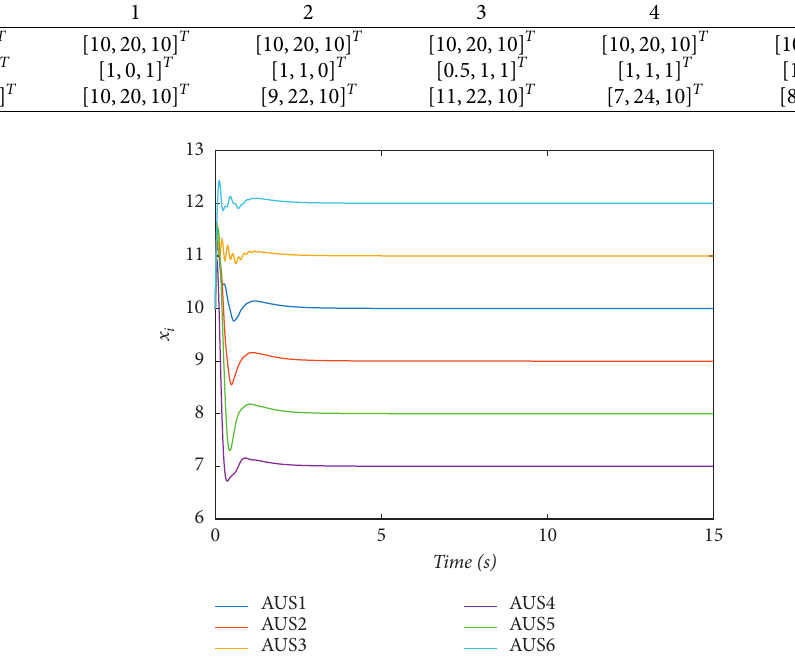
Figure 3: Trajectories of x position of CAUS.